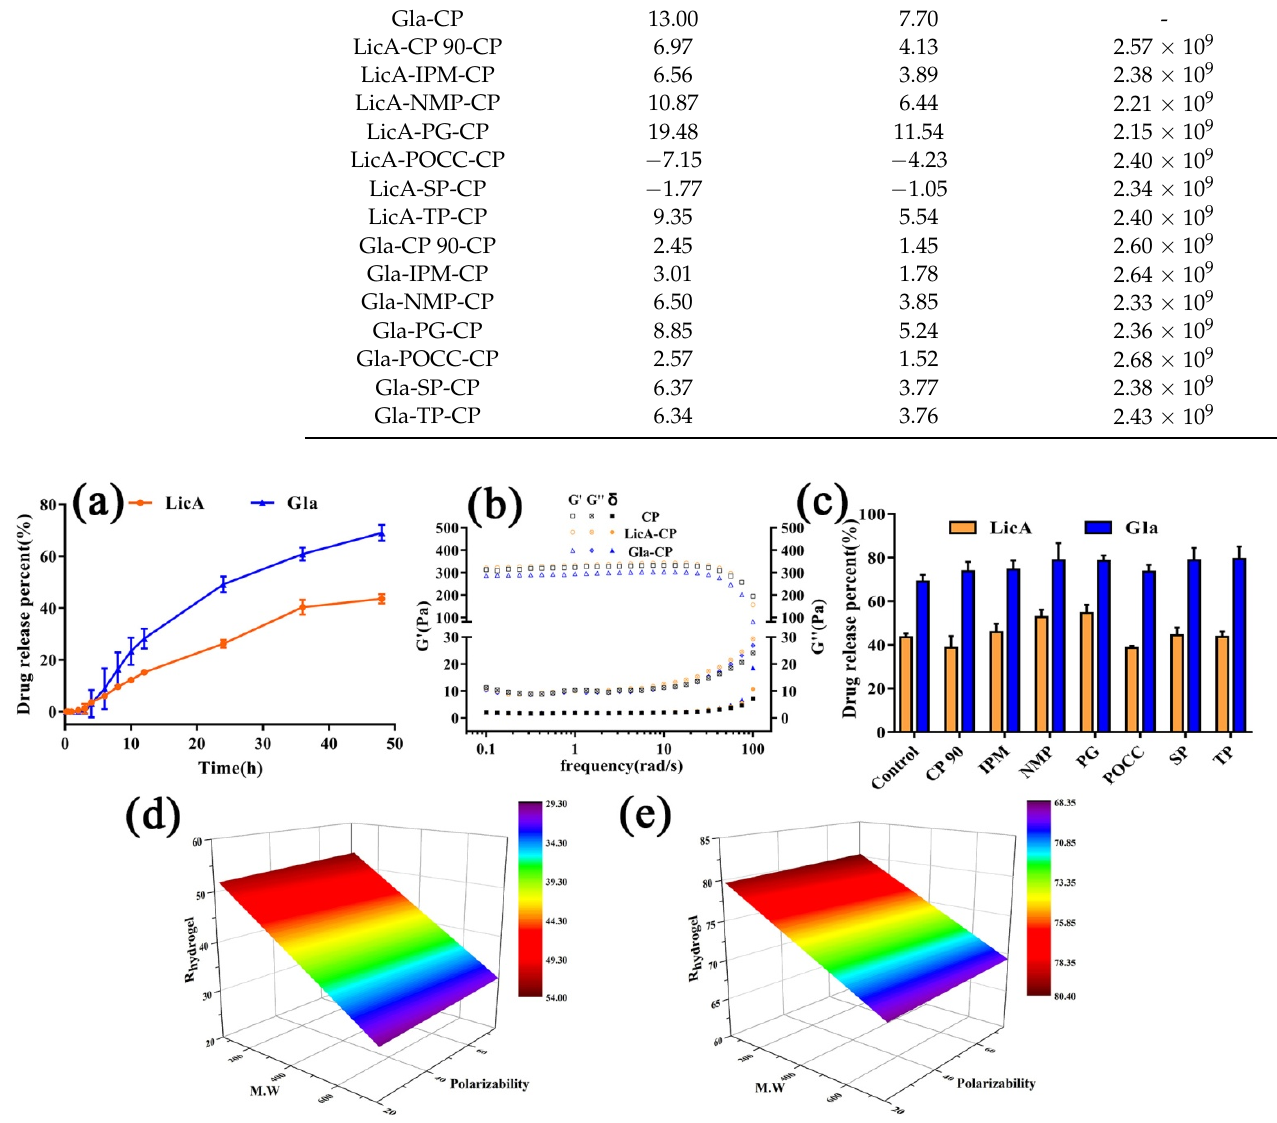
Figure 3. ( a ) In vitro drug release profiles of hydrogel ( n = 3); ( b ) frequency sweep (G ′ , G ′′ , and δ ) of the hydrogel ( n = 3); ( c ) LicA and Gla release percent after48 h after different enhancers were added (n = 3); ( d ) response surface plot demonstrating the effect of MW and polarizability on the ER release of LicA; ( e ) response surface plot demonstrating the effect of MW and polarizability on the ER release of Gla.